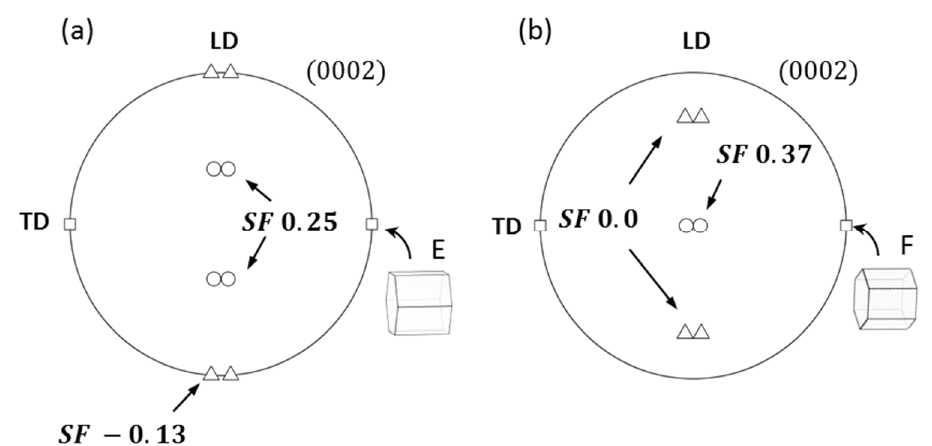
Figure 23. Basal pole figures showing the initial orientations ( a ) E and ( b ) F depicted by squares as well as the corresponding 1012 extension twin variants (triangles and circles). Circles indicate the experimentally observed high Schmid factor (SF) twin variants.